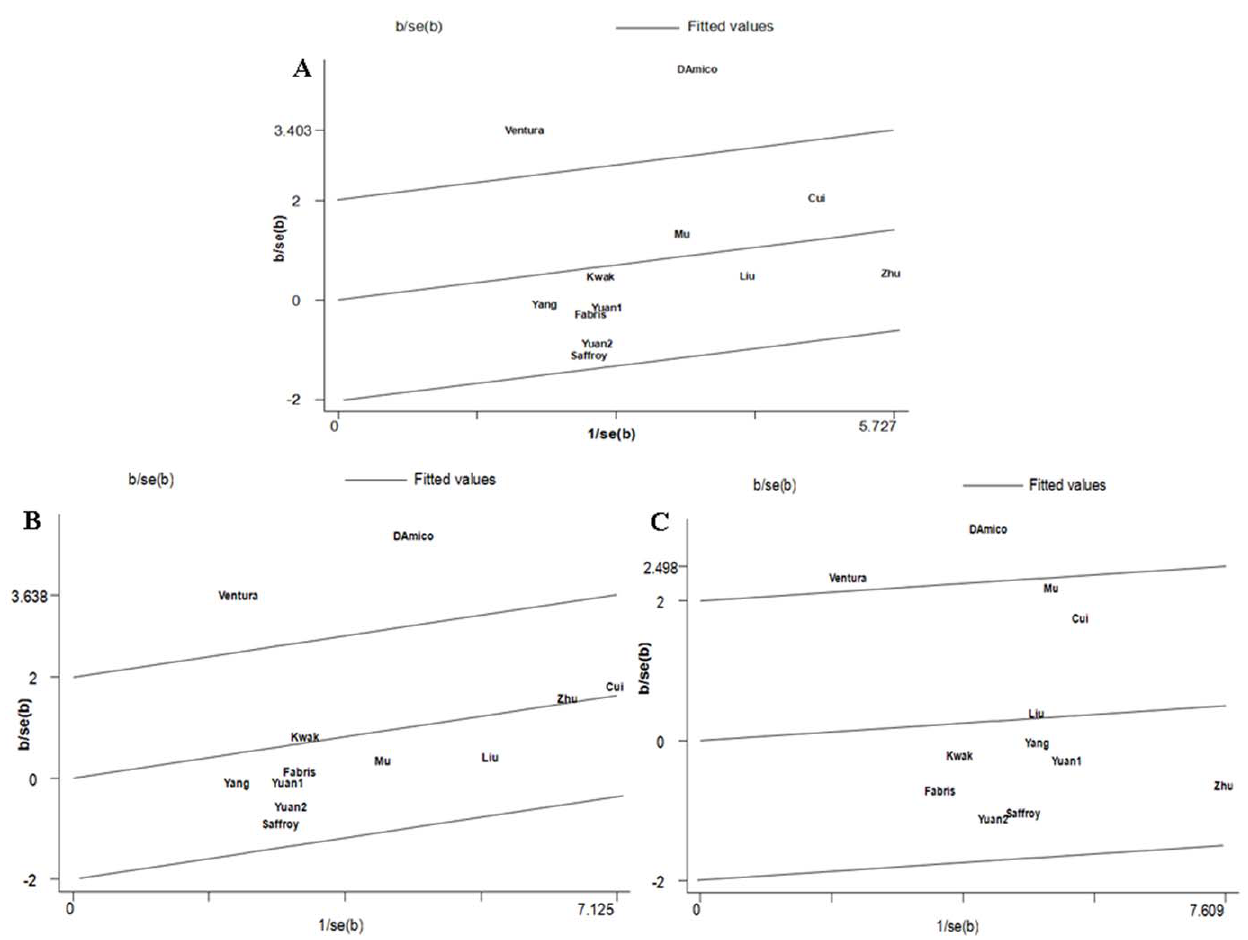
Figure 3. Galbraith plots of C677T polymorphism and HCC risk in different contrast models. A The studies of Ventura et al., D’Amico et al. were outliers in the contrast TT vs. CC. B The studies of Ventura et al., D’Amico et al. were outliers in the recessive model TT vs. CT + CC. C The studies of Ventura et al., D’Amico et al. were outliers in the dominant model TT + CT vs. CC.